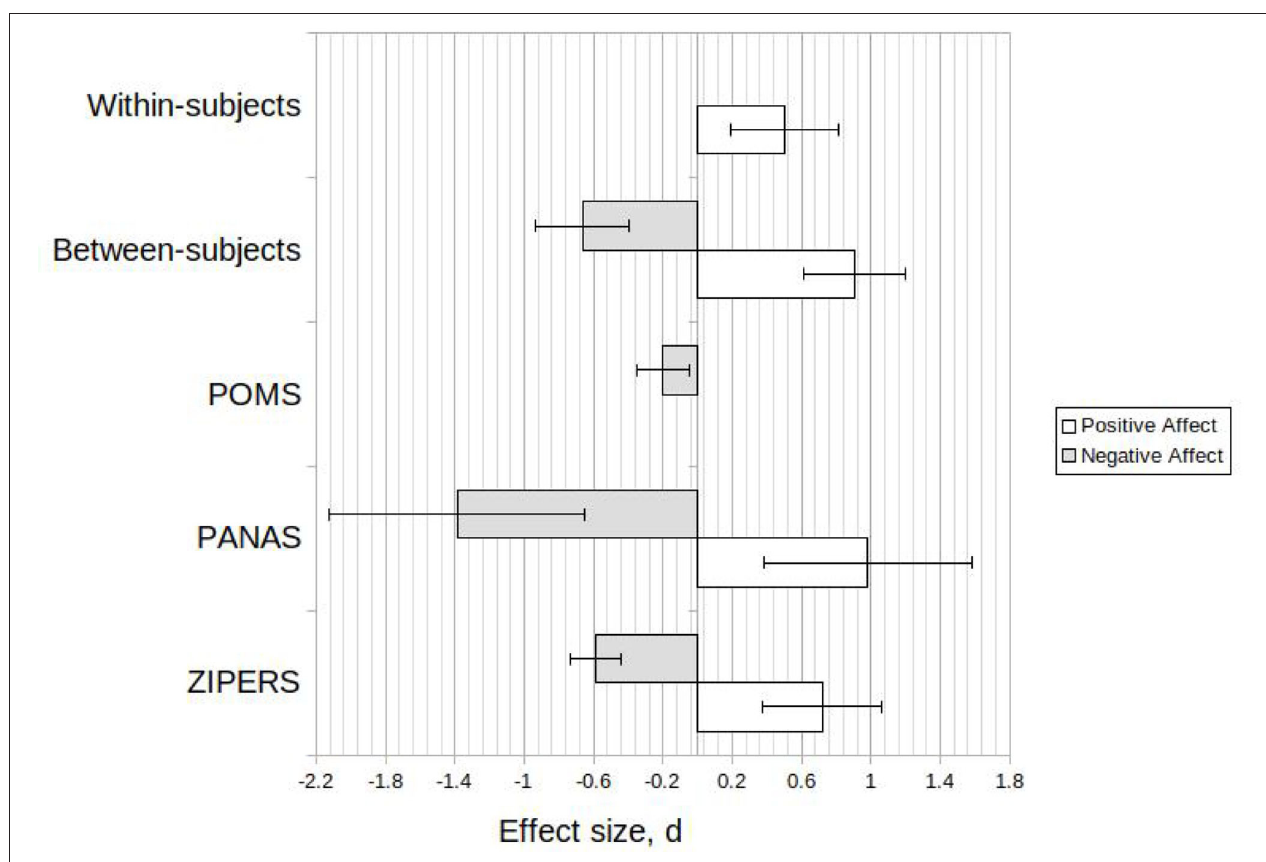
FIGURE 3 | Calculated effect sizes, d, for laboratory simulation only data set and various experimental methods and outcome measures (Mean ±